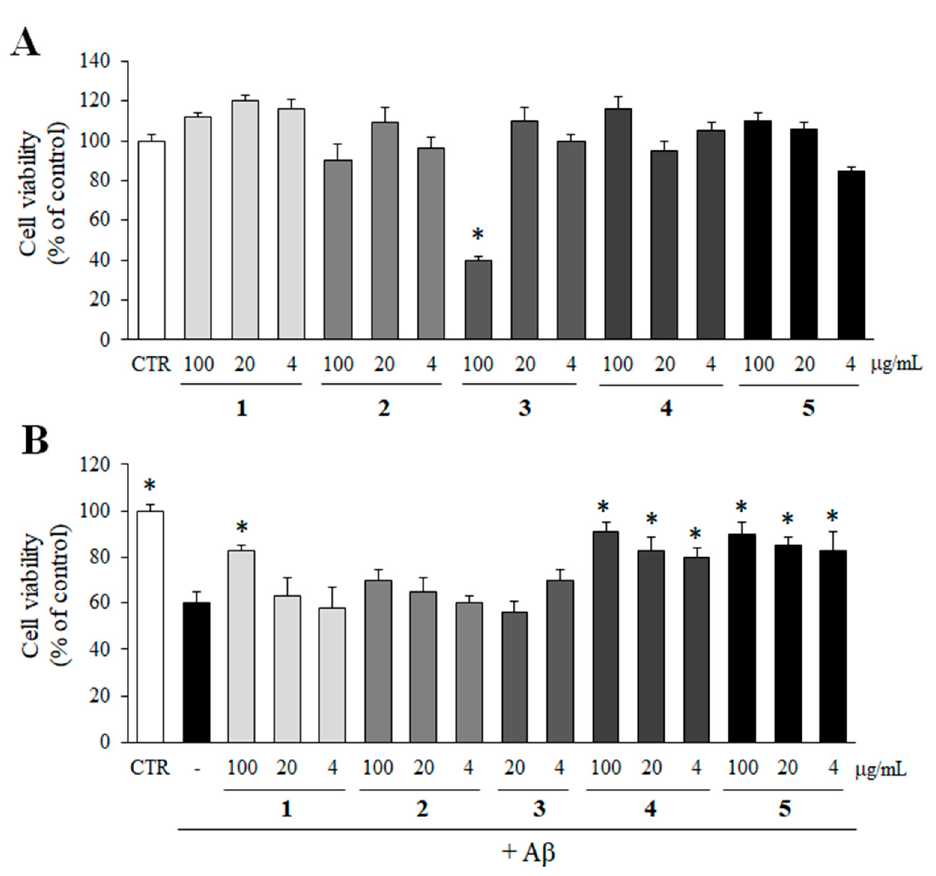
Figure 6. Inhibitory effect of compounds 1 – 5 on A β aggregate-induced toxicity. ( A ) The cytotoxicity of compounds 1 – 5 (100, 20, and 4 µ g/mL) on PC12 cells was determined by MTT assay. ( B ) Pre- aggregated A β was incubated with compounds 1 – 5 for 24 h. In case of control group, DMSO was added instead of test samples. Then, PC12 cells were treated with the mixture of A β and compounds 1 – 5 for additional 24 h, and the viability of the cells was determined by MTT assay. All data represent the mean ± SD of three different experiments. * p < 0.05, significantly different from A β only group.